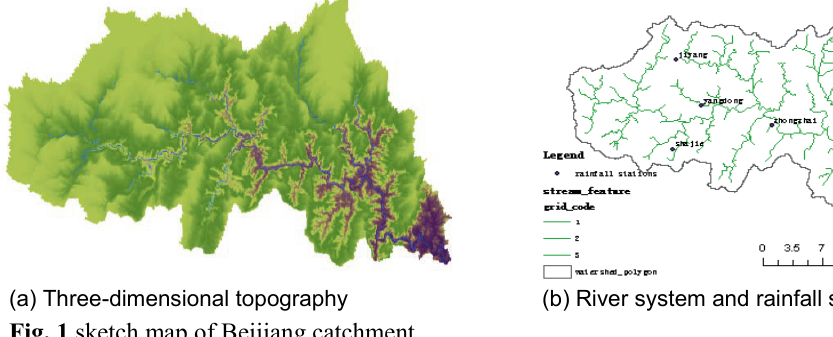
Fig. 1 sketch map of Beijiang catchment.